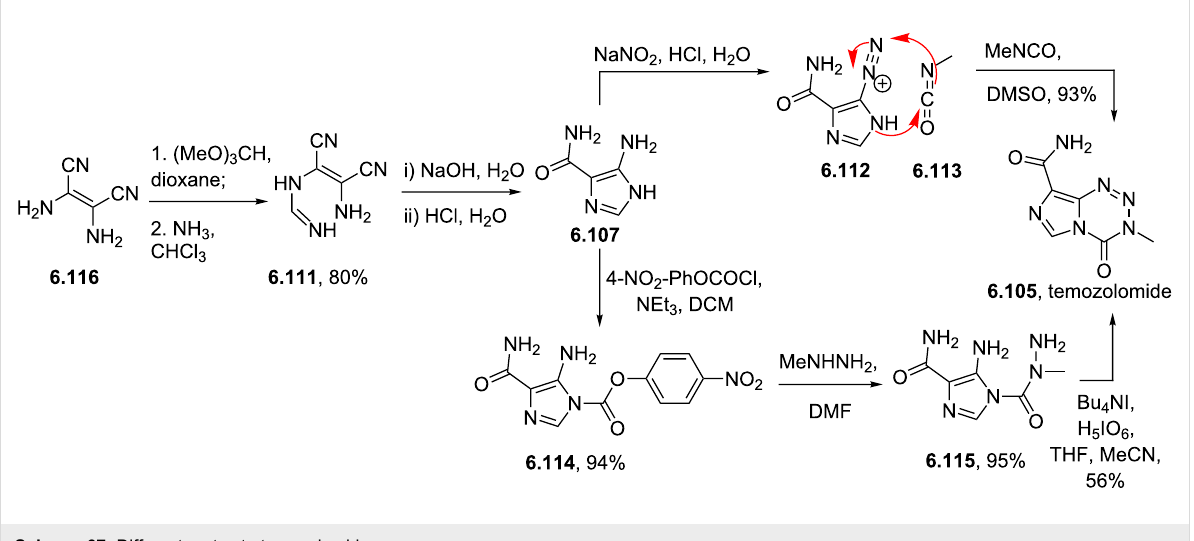
Scheme 67: Different routes to